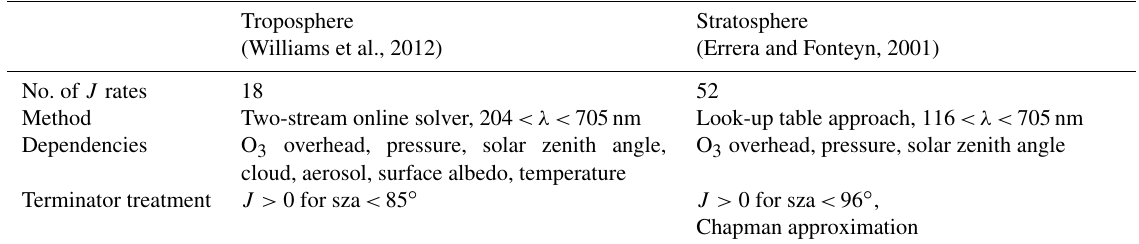
Table 3. Parameterization of photolysis rates for the troposphere (CB05-based) and stratosphere